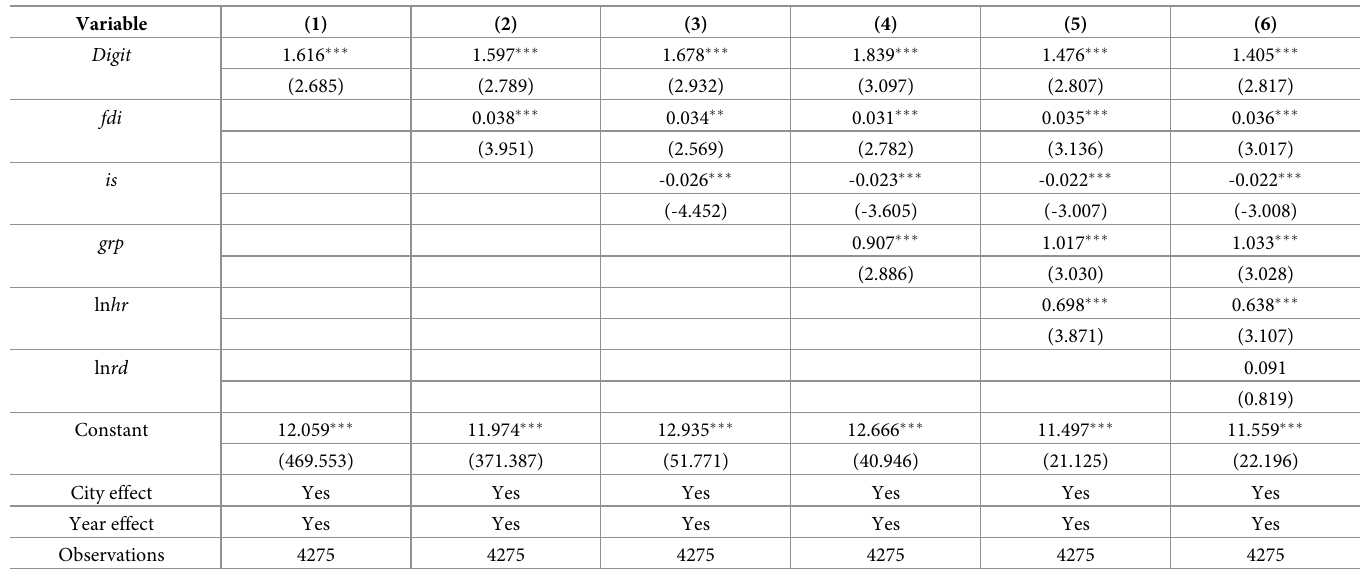
Table 2. Results of the benchmark